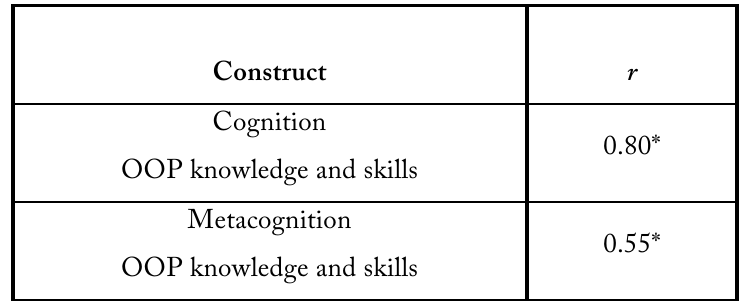
Table 3: Correlations between cognition, metacognition and OOP knowledge and skills of